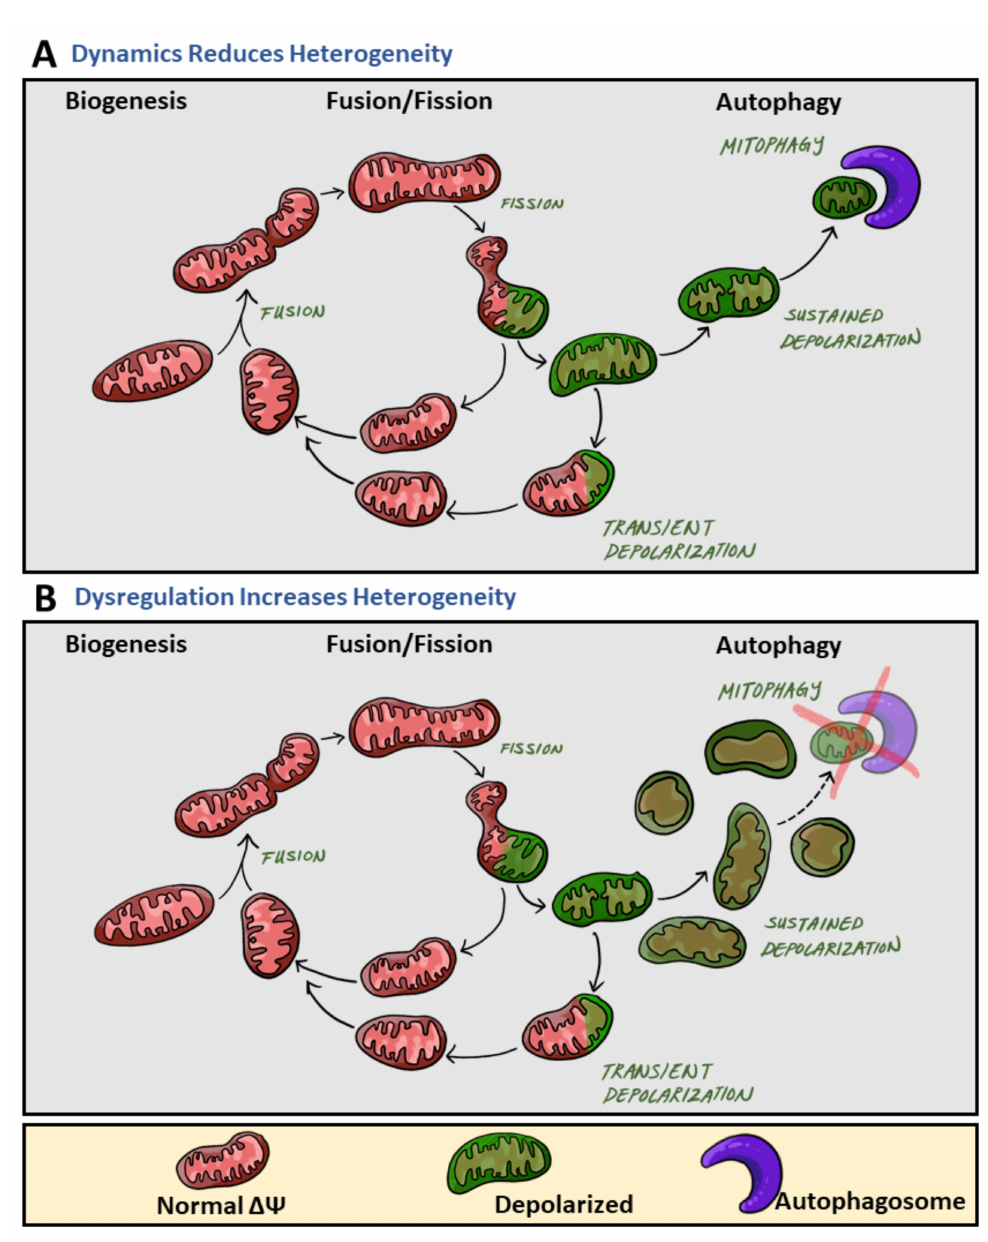
Figure 1. The role of mitochondrial dynamics in mitochondrial heterogeneity. During the mitochondrial life cycle, mitochondrial heterogeneity primarily occurs at three main phases (from left to right): biogenesis, fusion/fission, and autophagy of mitochondria (mitophagy). ( A ) While increases in mitochondrial heterogeneity are beneficial to cellular health, sustained activity of the mitochondrial life cycle reduces mitochondrial heterogeneity. Specifically, fusion events result in the contents of two different mitochondria mixing, ultimately resulting in their contents becoming the same, equilibrating the mitochondrial population within the cell, and thereby decreasing intracellular heterogeneity. After fission, one daughter mitochondrion will depolarize (green) while the other will maintain normal membrane potential (red). Depolarized mitochondria will undergo one of two fates: either a transient depolarization will occur and they will slowly regain their membrane potential to fuse again (green mitochondria back to red), or they will remain depolarized and undergo mitophagy (the mitochondria will remain green). Mitophagy events remove depolarized mitochondria from the mitochondrial population, thereby reducing intracellular membrane potential heterogeneity. ( B ) Dysregulation and blockades within the mitochondrial life cycle lead to increases in heterogeneity. Impaired clearance of mitochondria with sustained depolarization, via mitophagy, increases the pre-autophagic pool. Increasing the pre-autophagic pool size increases intracellular heterogeneity, and the mitochondrial population now transitions from a population with a common membrane potential (red) to one with multiple membrane potentials (red and